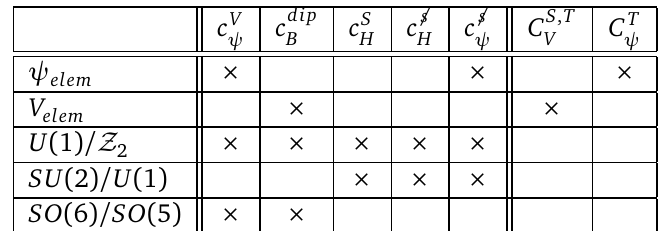
Table 2: × denotes suppression of a given EFT coefficient, according to specific properties of the microscopic dynamics: ψ denotes the limit where SM fermions are not composite, V elem denotes instead the familiar case where the transverse polarizations of vectors are elementary (as opposed to strong multipolar interactions [ 22 ]